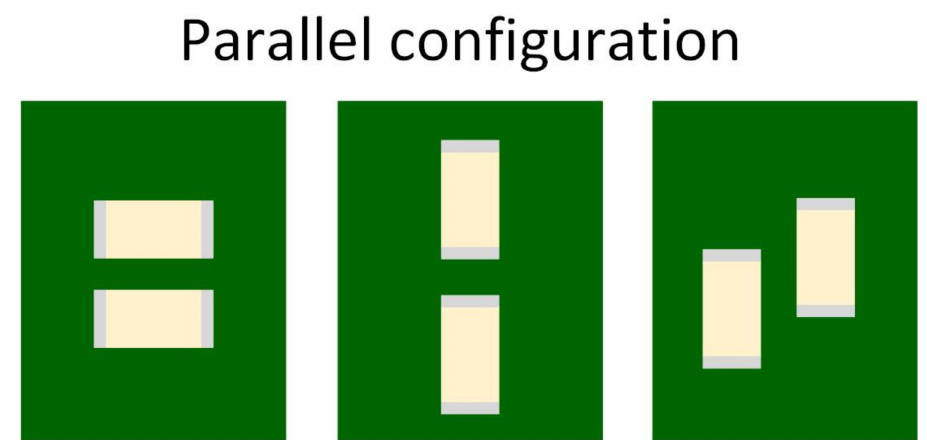
Figure 11. Parallel layout geomery.